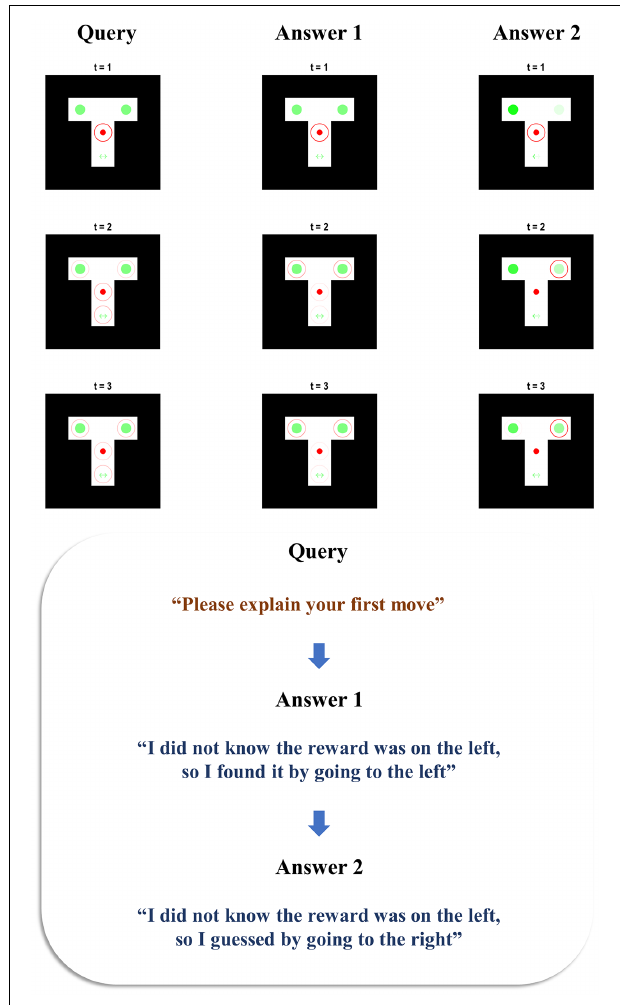
FIGURE 5 | Confabulation . This figure reports the behaviour of an agent who confabulates an answer as to why it pursued the course of action that it did, in virtue of never having pursued any course of action. It is given two opportunities to explain itself. The first answer given is nonsensical, as the generative model assumes that going straight to the